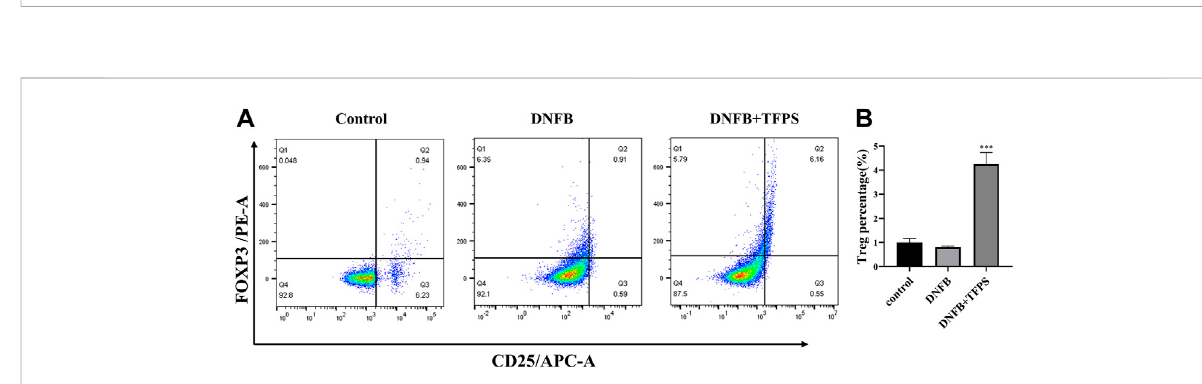
FIGURE 5 EffectsoforaladministrationofTFPSonTregnumberinmesentericlymphnodes(MLNs)ofADmice. (A)